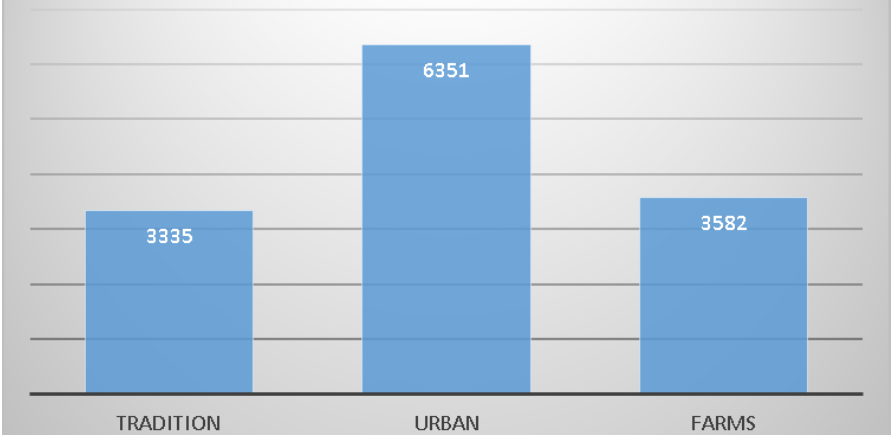
Fig. 1. Average earnings by geo-type in South Africa (2008-2012)